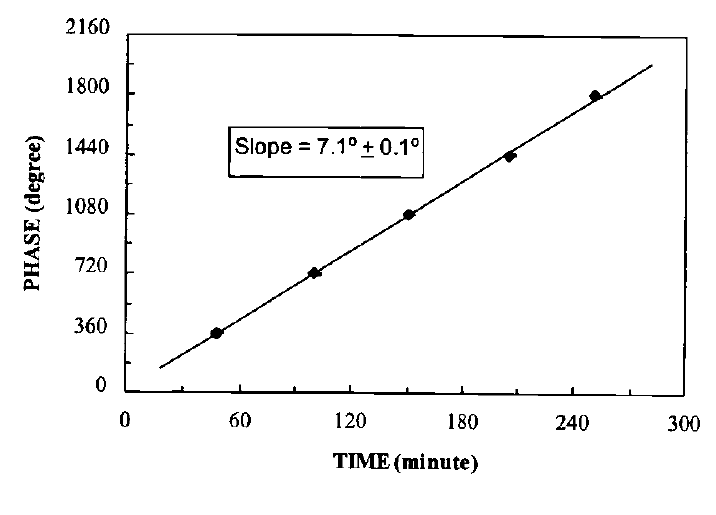
Figure 17. The data shown in Figure 16 are plotted to reveal phase variation as a function of time